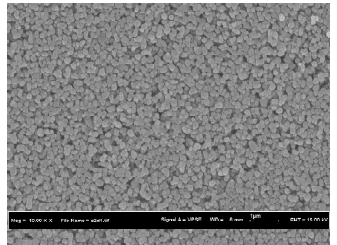
Figure 1. SEM Micrograph of TiO immobilised on cement